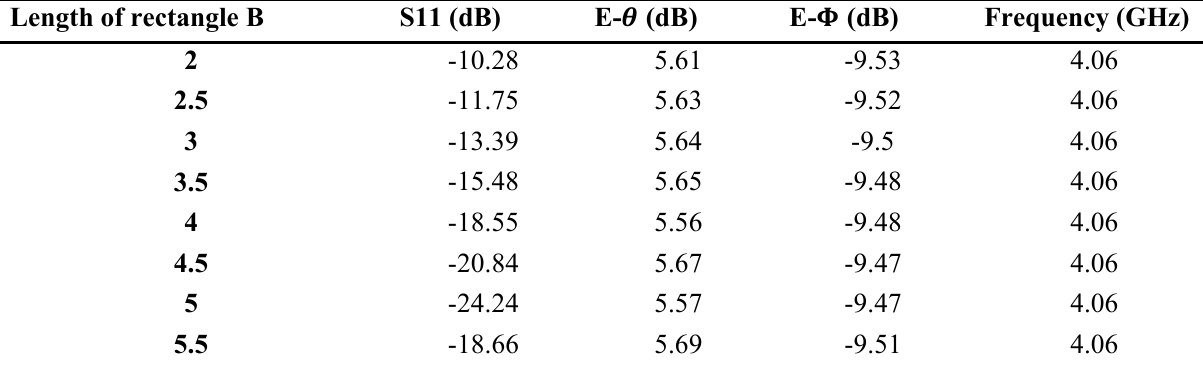
Table 2. Results of second parametric study